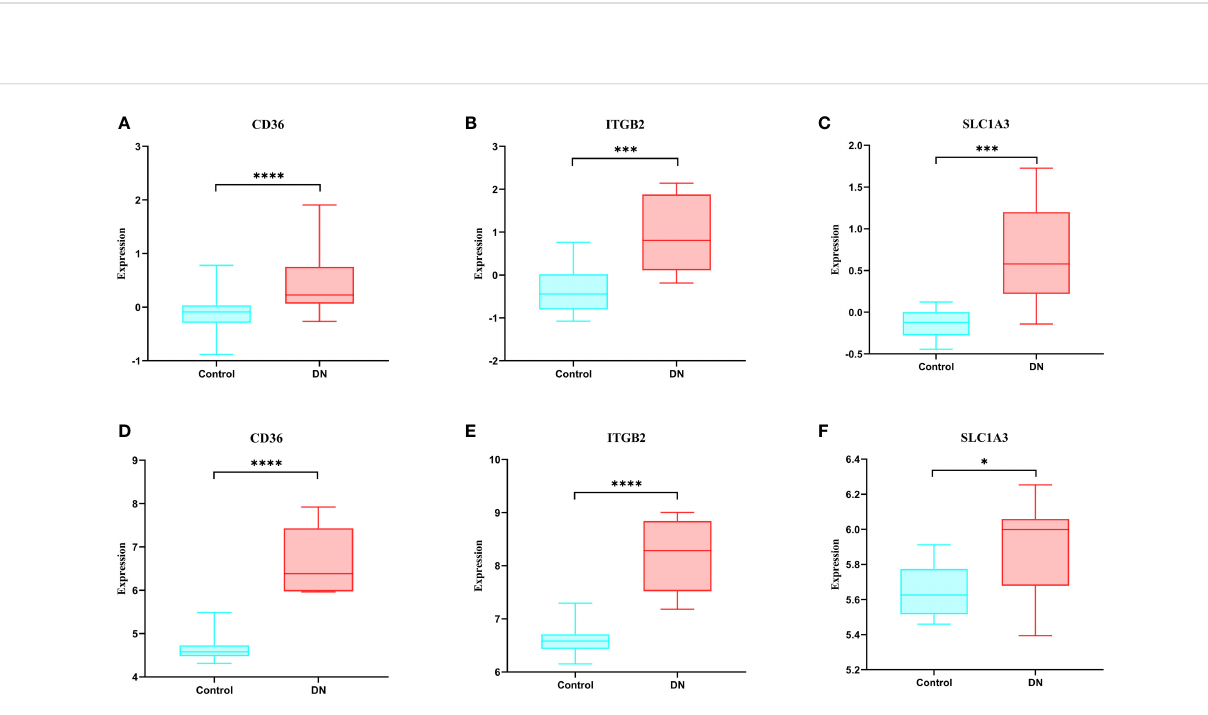
(Figure 12A), among which CD36 was mainly distributed in endothelium and ITGB2 and SLC1A3 were highly expressed in leukocyte (Figures 12B-D).